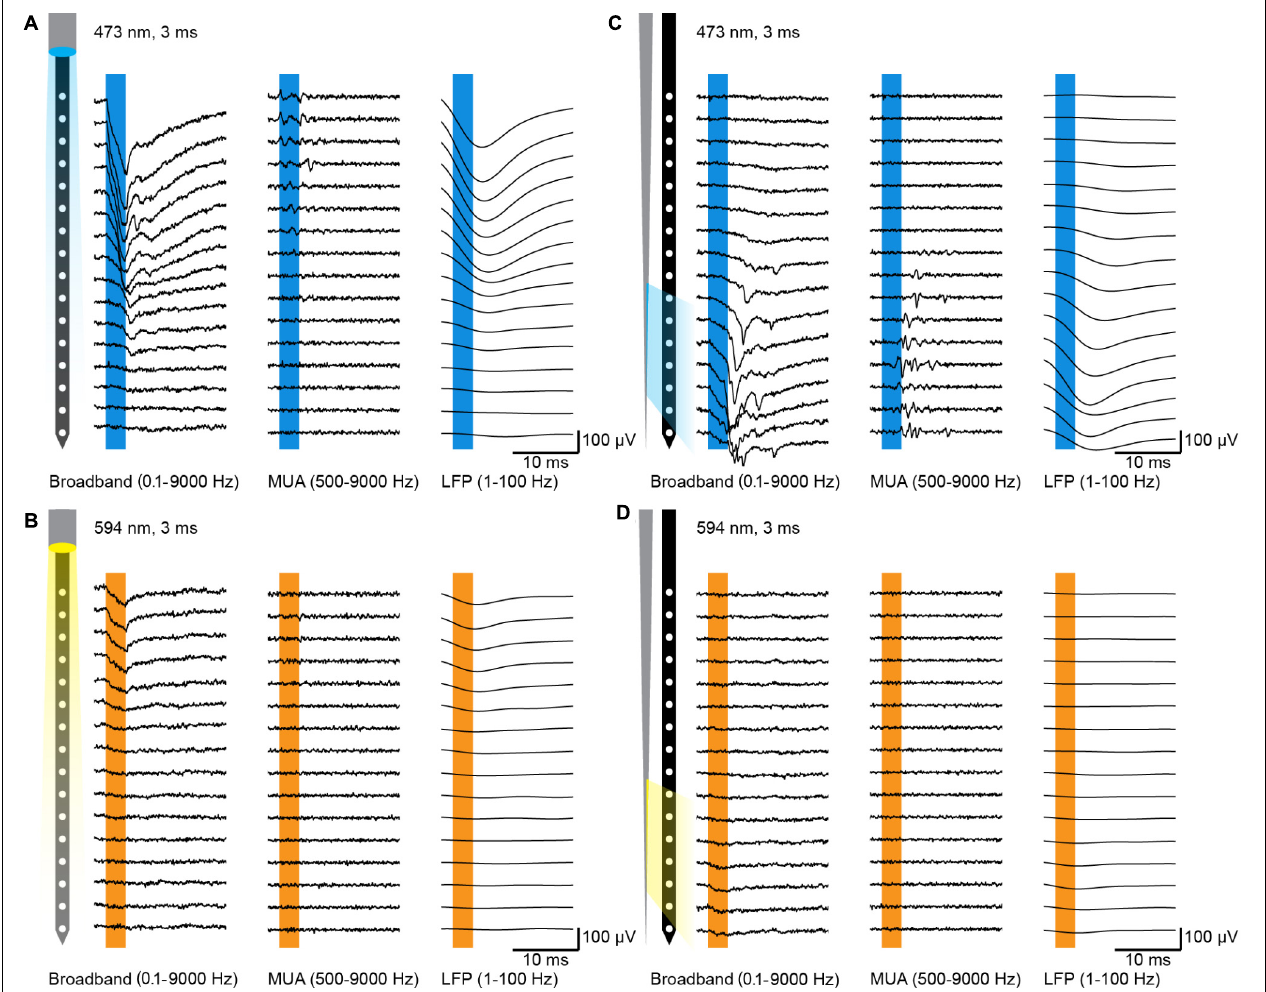
FIGURE 3 | Typical electrophysiology recordings with FF- and TF-based optrodes. (A) Characteristic extracellular multi-site recording of light-induced activity (3 ms pulse, 473 nm) with illumination from the top in the mPFC of a neonatal mouse expressing ChR2(ET/TC) in layer 2/3 pyramidal neurons transfected by IUE. (B) Same as A for stimulation with yellow light (3 ms pulse, 594 nm) to trigger pure light artifact. (C,D) Same as A,B for illumination from the side with a